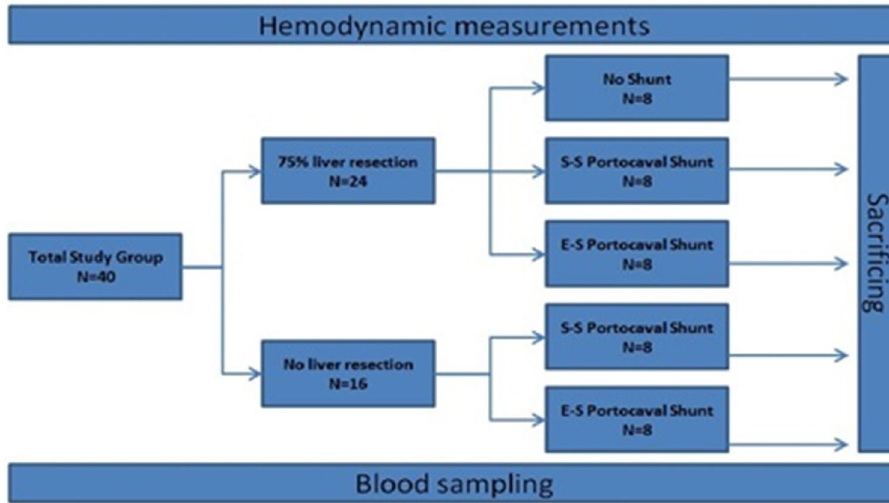
Figure 4. Study design.